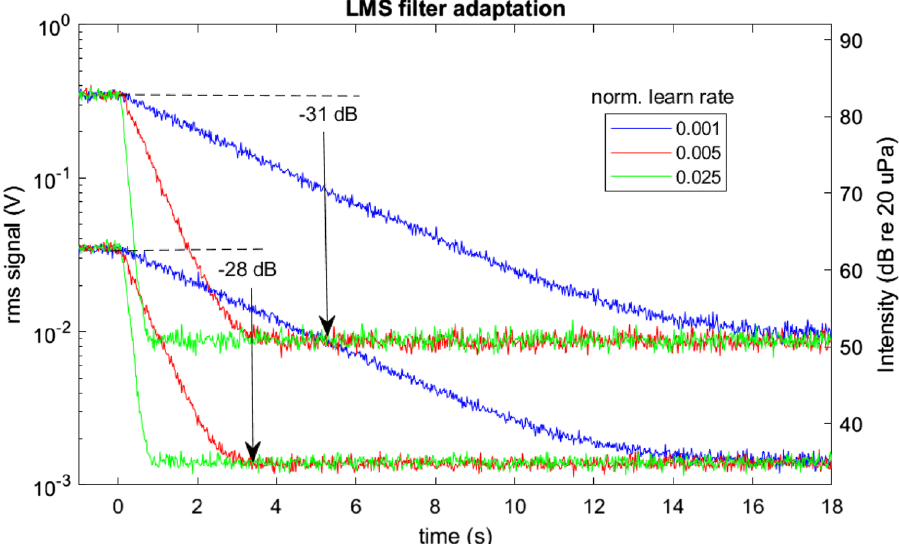
Figure 9. Rapid training of the LMS echo attenuation filter, shown for noise intensities of 63 dB (bottom three curves) and 83 dB (top three curves). In each case, three different normalized learning rates were tested: M = 0.001, 0.005, and 0.025. The filters achieved a suppression of roughly 30 dB. The limiting factor for the lower-intensity noise was the 32.5 dB noise floor of the microphone. The adaptation process works well with 65 dB noise, a learning time of 1–2 s, and a normalized learning rate of M = 0.025.